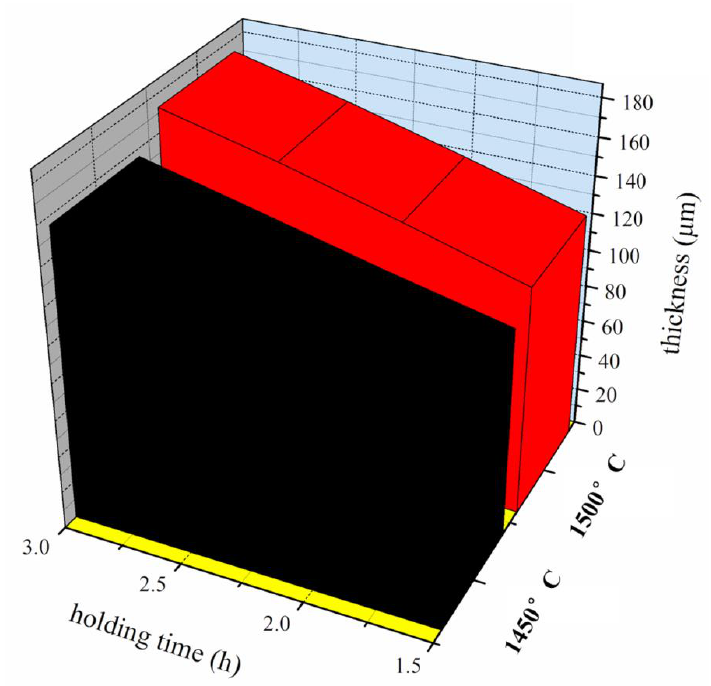
Figure 12. Relationship between holding time and the interfacial layer thickness.